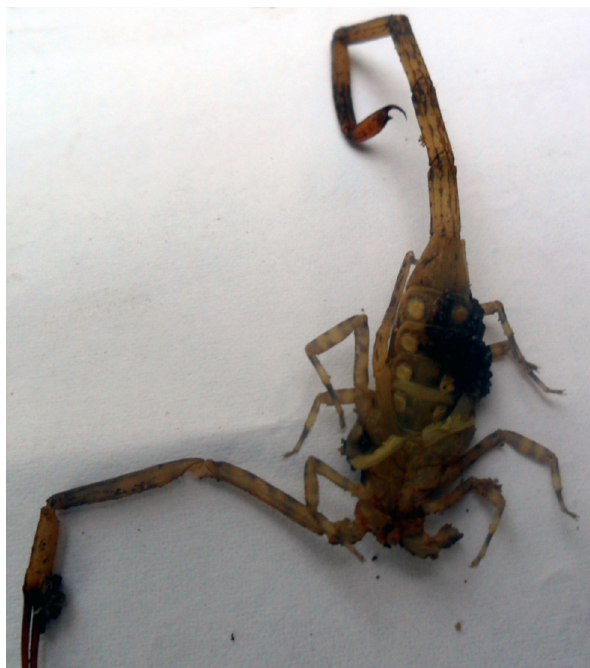
Figure 2. Yellow scorpion, the most frequent form in the study area.